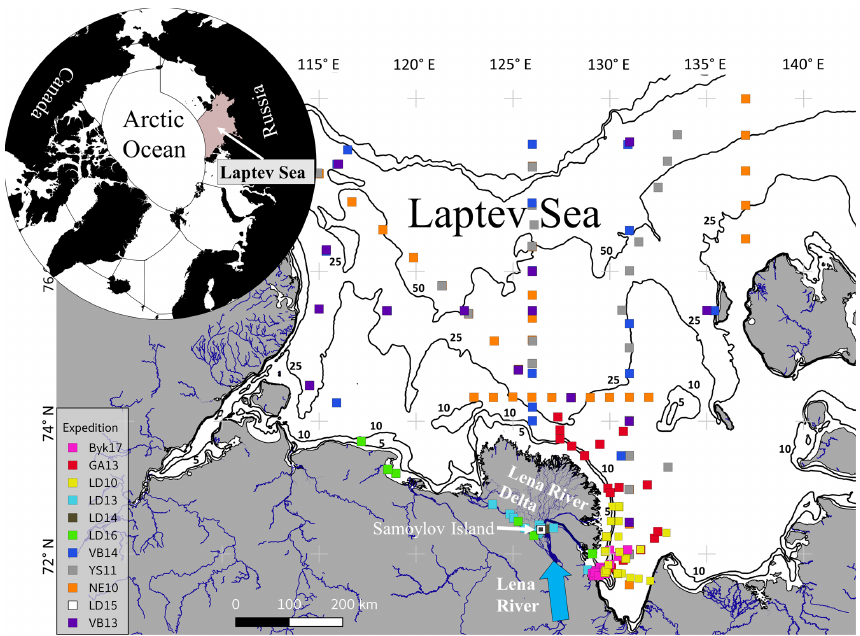
Figure 1. Map of the Laptev Sea and the Lena River Delta region with sample locations from 11 Russian–German expeditions; upper left map shows the Arctic Ocean and the location of the Laptev Sea on the Russian Arctic shelf. Bathymetry is shown by black contour lines and water depth in